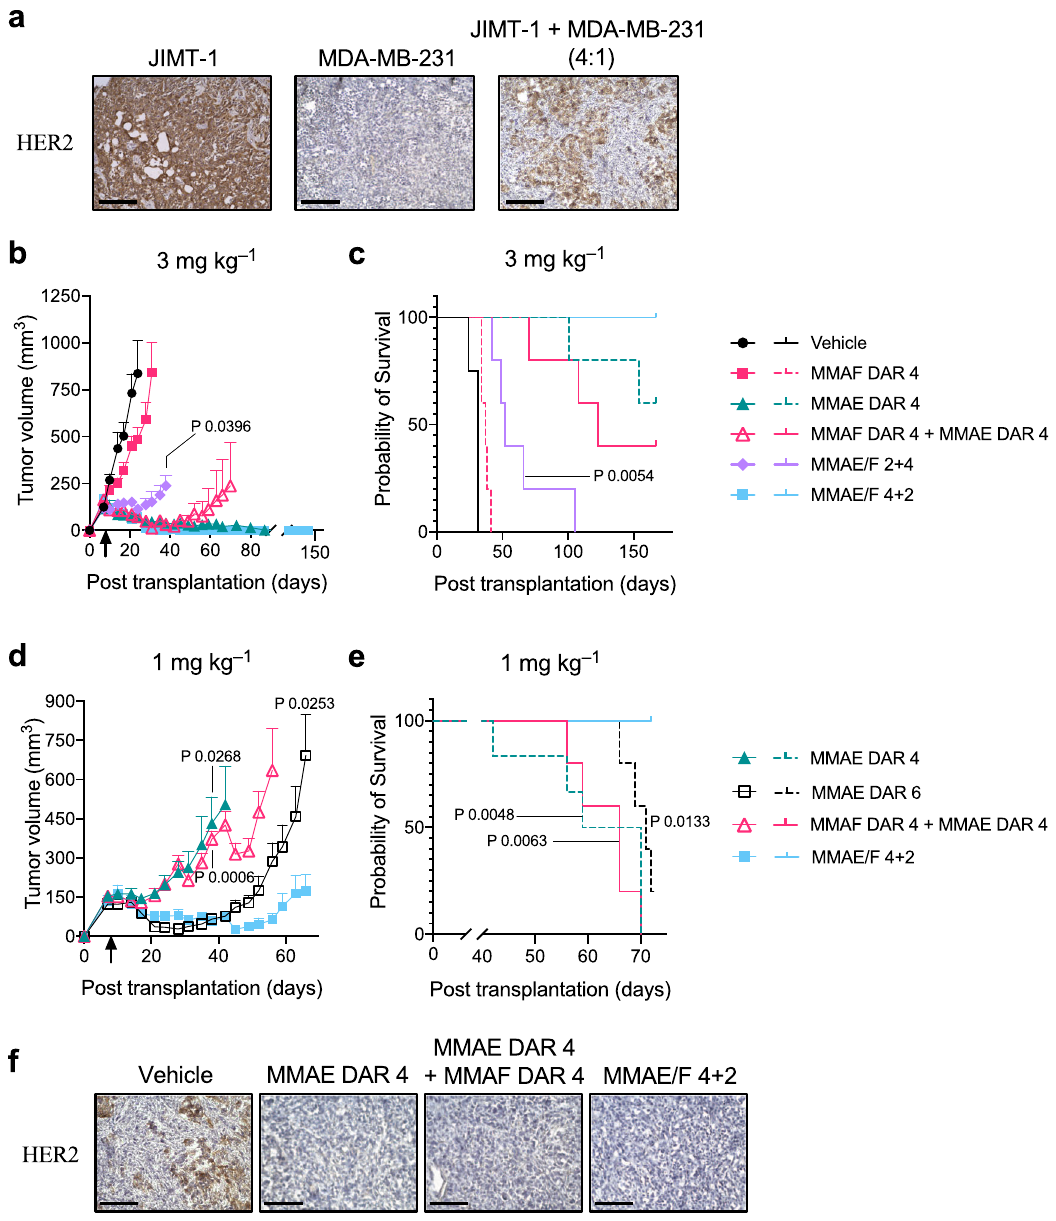
Fig. 5 In vivo antitumor activity of dual-drug ADCs in the JIMT-1/MDA-MB-231 admixed model. a HER2 expression on tumors consisting of either HER2-positive JIMT-1 or HER2-negative MDA-MB-231 cells, or both (4 : 1 ratio at the time of implantation). Immunohistochemistry for HER2 was performed on frozen sections of each tumor. Scale bar: 200 µ m. This experiment was repeated twice independently with similar results. b – e Antitumor activity ( b , d ) and survival bene fi t ( c , e ) of each ADC in the JIMT-1/MDA-MB-231 admixed orthotopic breast tumor model (female NU/J mice, n = 4 for vehicle; n = 6 for MMAE DAR 4 at 1 mg kg − 1 ; n = 5 for all other groups). Tumor-bearing mice were treated with each ADC at 3 mg kg − 1 ( b , c ) or 1 mg kg − 1 ( d , e ). At day 8 post transplantation (indicated with a black arrow), mice were administered with a single dose of MMAF DAR 4 ADC (magenta square), MMAE DAR 4 ADC (green triangle), MMAE DAR 6 ADC (black open square), a 1 : 1 mixture of MMAF DAR 4 and MMAE DAR 4 ADCs (magenta open triangle, 3 or 1 mg kg − 1 each), MMAE/F 2 + 4 ADC (light purple diamond), MMAE/F 4 + 2 ADC (cyan square), or vehicle control (black circle). All animals other than the ones that were found dead or achieved complete remission were killed at the pre-de fi ned humane endpoint (see “ Methods ” ), which were counted as deaths. Data are presented as mean values ± SEM. For statistical analysis, a two-tailed Welch ’ s t -test (for tumor volume) and a log-rank test (for survival curve) were used. To control the family-wise error rate in multiple comparisons, crude P -values were adjusted by the Holm – Bonferroni method (see Supplementary Table 4 for details). f HER2 expression of regrown tumors after treatment with MMAE DAR 4 ADC (1 mg kg − 1 ), a 1 : 1 mixture of MMAF DAR 4 and MMAE DAR 4 ADCs (1 mg kg − 1 each), and MMAE/F 4 + 2 ADC (1 mg kg − 1 ). Each tumor was collected when its size reached 1000 mm 3 and fi xed with 4% PFA. Immunohistochemistry for HER2 was performed on frozen sections. Scale bar: 100 µ m. This experiment was repeated twice independently with similar results. Source data are available as a Source Data fi le.